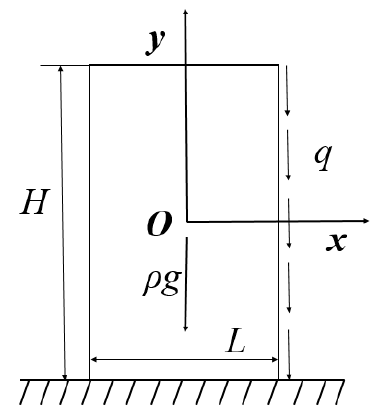
Figure 10. Computational domain.